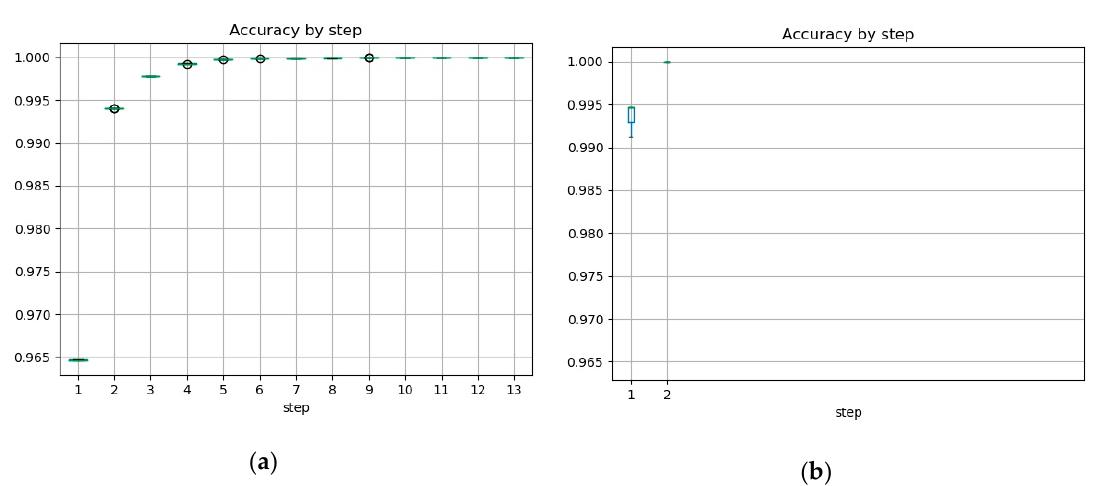
Figure 4. Accuracy of the trained models at each step, shown as boxplots: ( a ) from the NSL-KDD dataset; ( b ) from the UCI-BCW dataset.